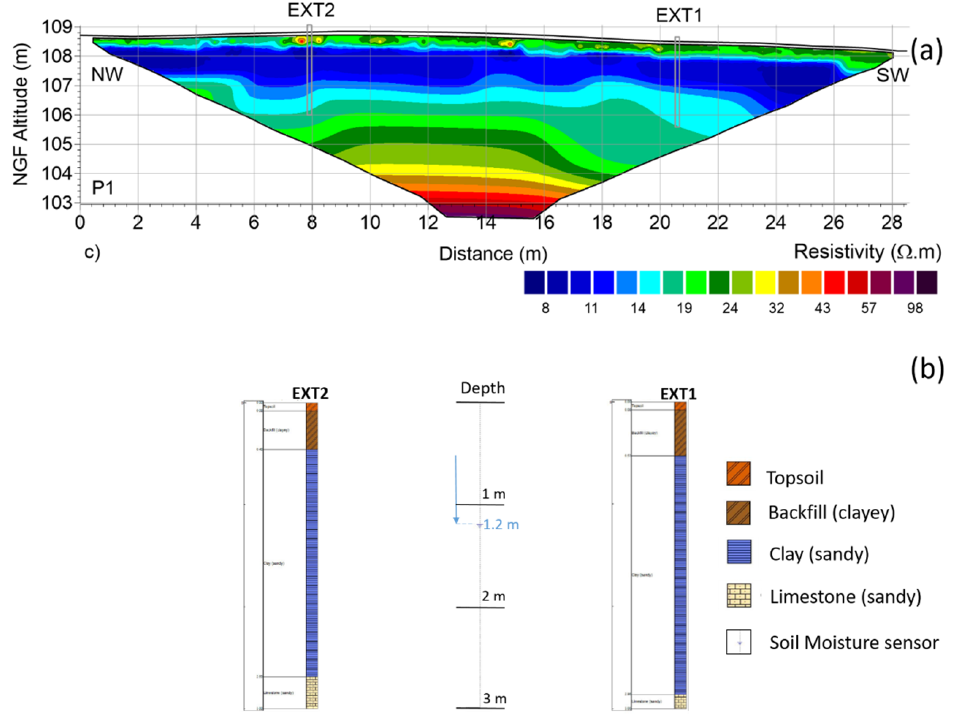
Figure 3. ( a ) Vertical cross section of resistivity along P1 profile (EXT1-EXT2). ( b ) Clay depth and thickness at EXT1 and EXT2 deduced from the resistivity profile (see text). E1 sensor (near EXT1, Figure 1) and W5 (near EXT2) are both located at the same 1.2 m depth inside the clay